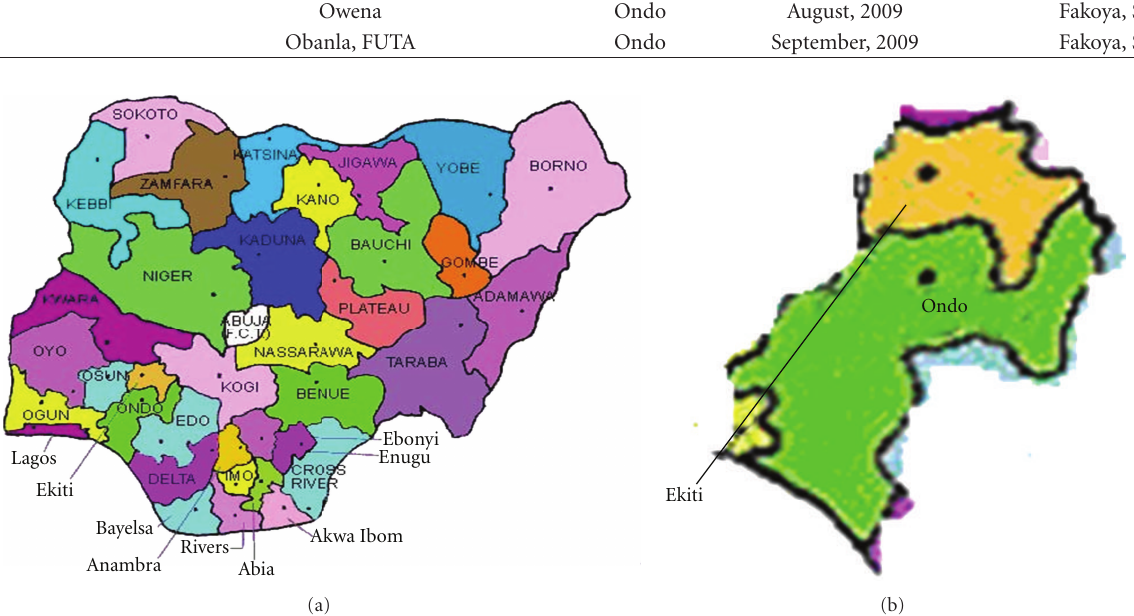
Figure 1: Map of Nigeria (a) and map of the states Ondo and Ekiti States (b) where Termitomyces samples were collected.